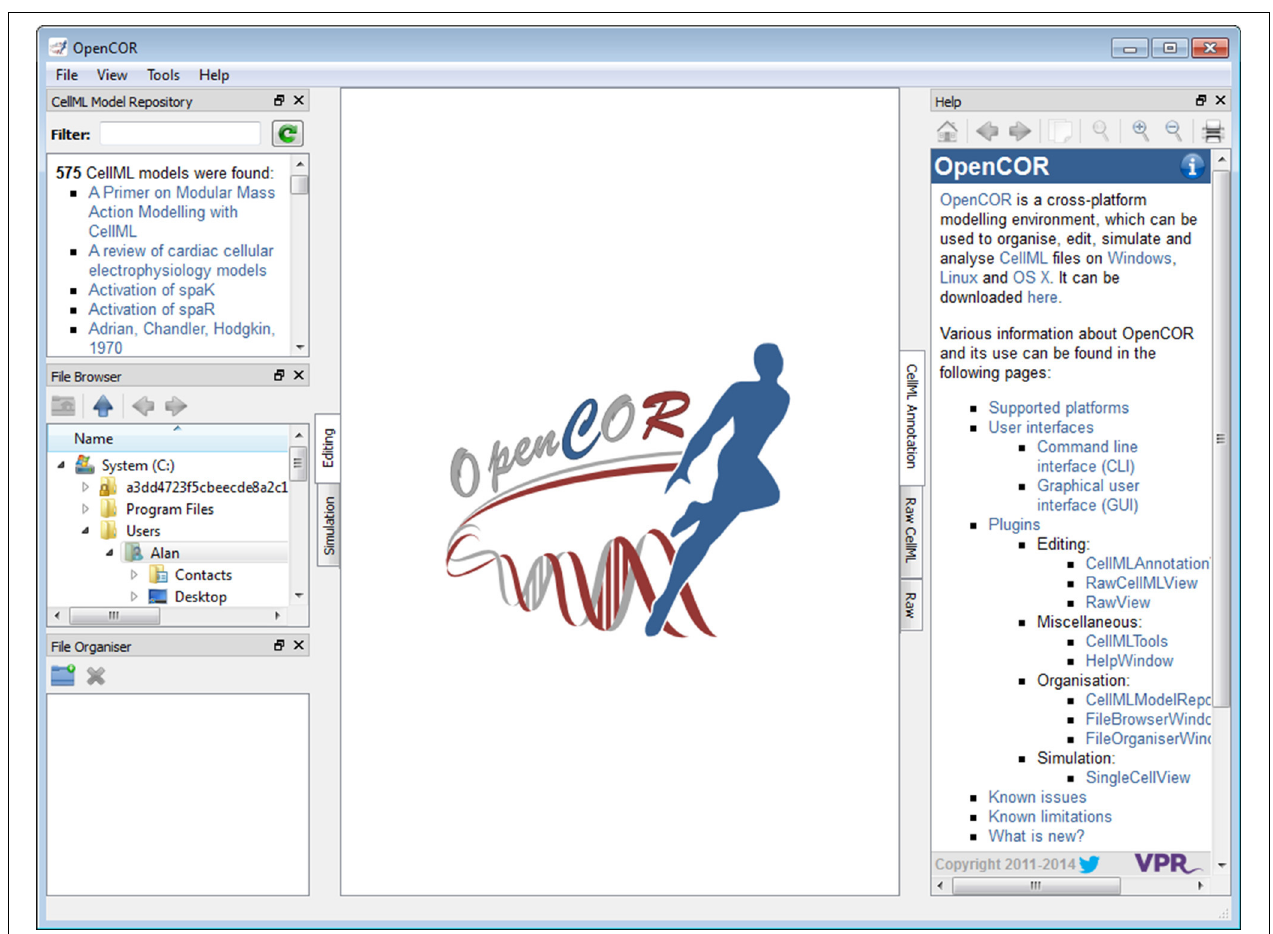
FIGURE 1 | Graphical user interface. The graphical user interface consists of a central area where files are loaded and rendered (the OpenCOR logo is shown, if no files are opened). The rendering of a file depends on the selected view (to the right of the central area). In the case of the Editing mode (to the left of the central area), the views currently available are the